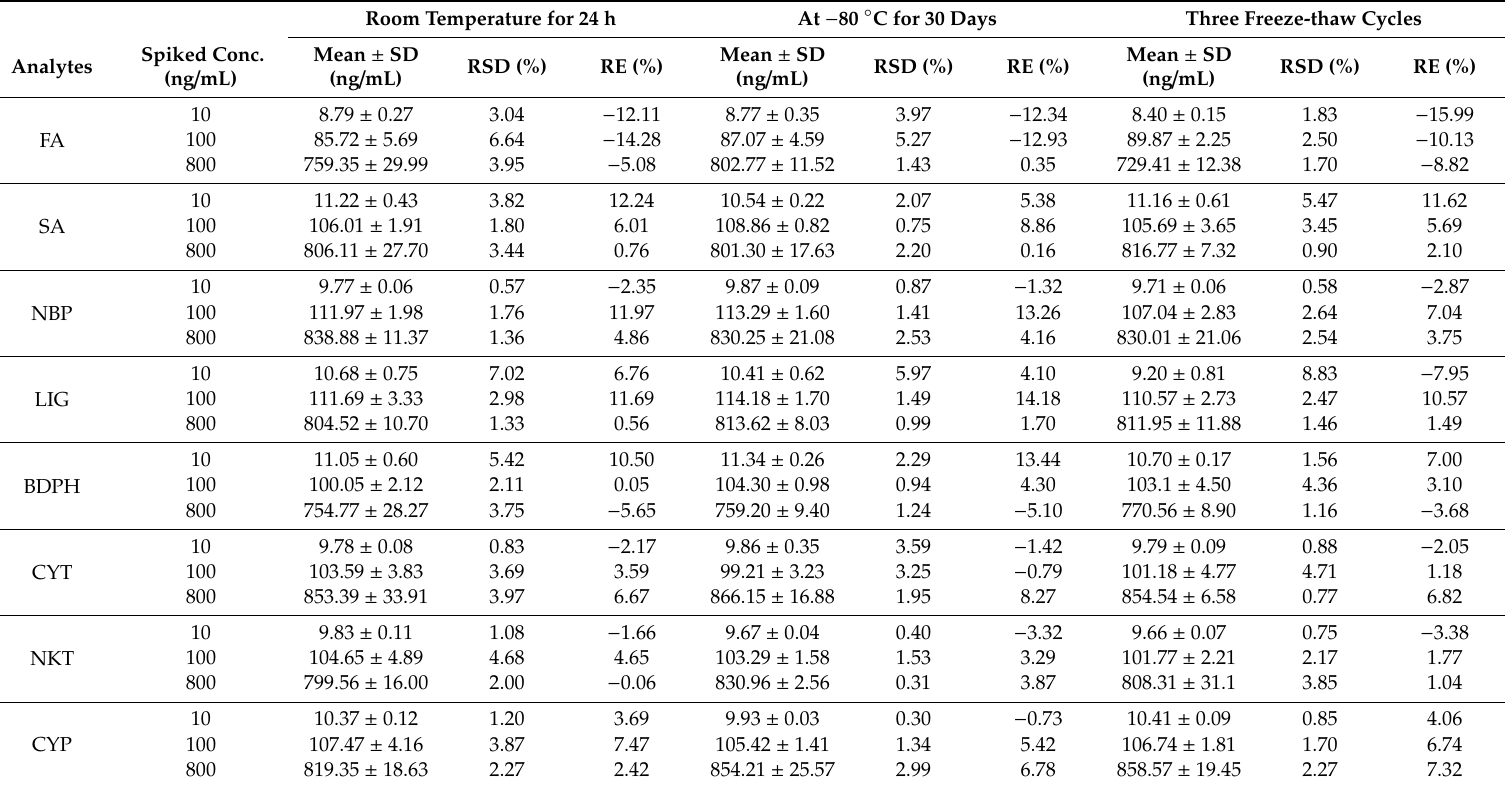
Table 5. Stability results of the analytes in rat serum under three di ff erent conditions ( n =